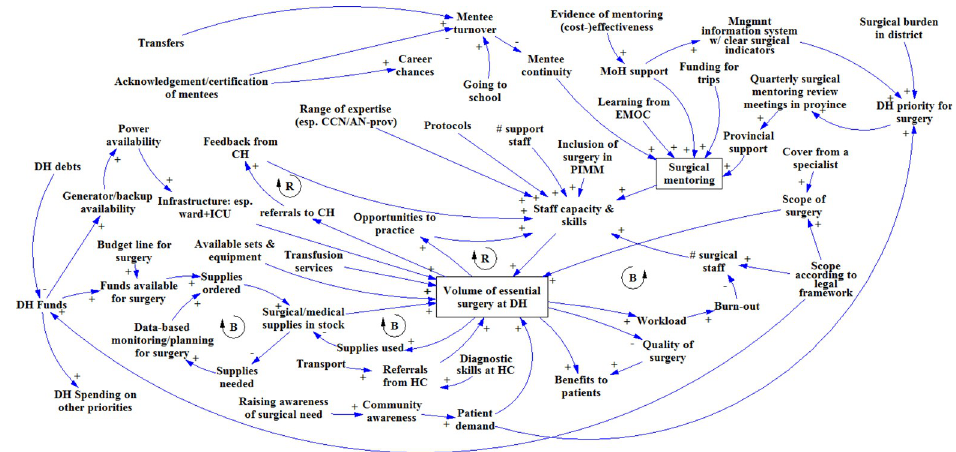
Fig 4. Causal loop diagram as it was built in the GMB workshop at Zimba Mission hospital.